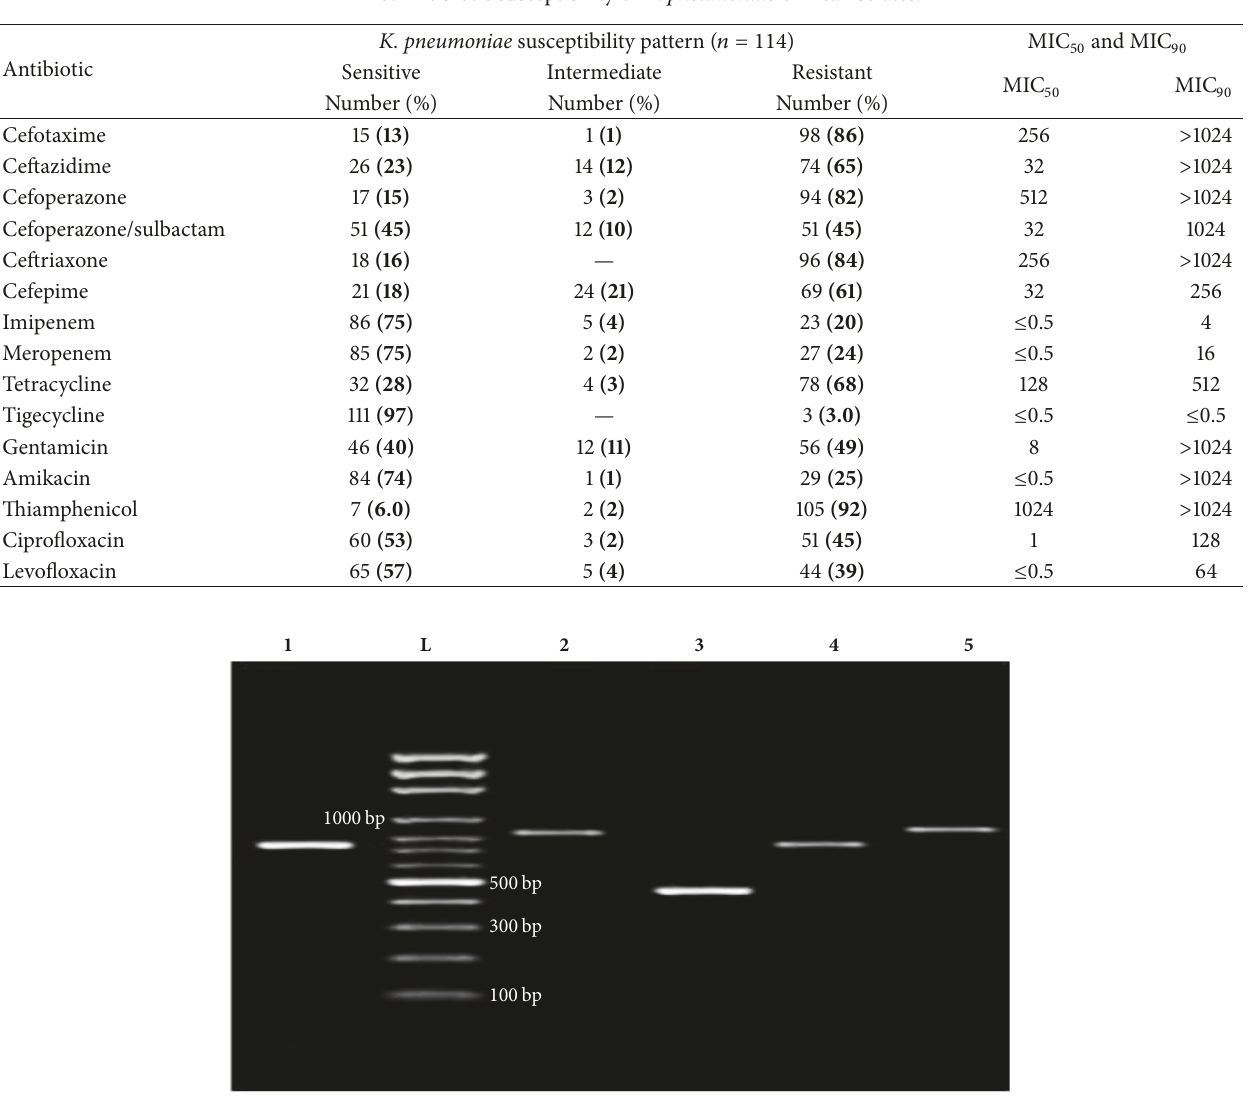
Table 3: Antibiotic susceptibility of K. pneumoniae clinical isolates.